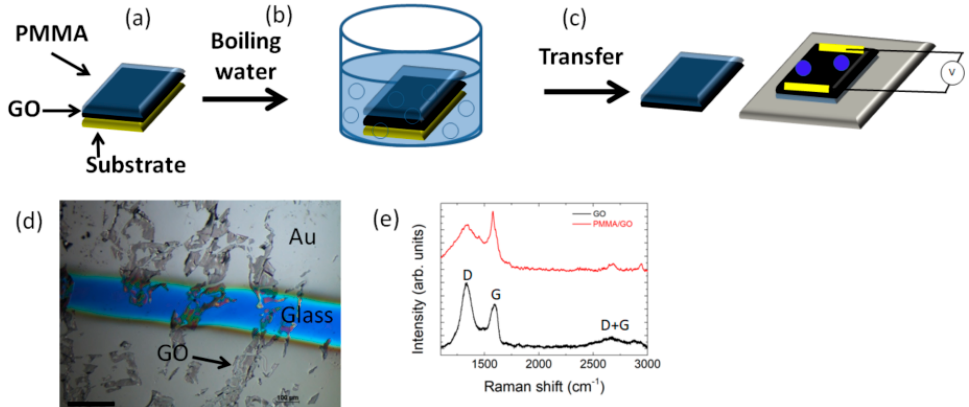
Figure 3. Scheme of transfer method of (GO). ( a ) poly(methyl methacrylate) (PMMA) was deposited on GO. ( b ) The substrate was then immersed in boiling water to promote the detachment of PMMA. ( c ) Transfer onto the target substrate. ( d ) Optical image of PMMA/GO on the target glass substrate between gold electrodes; the scale bar indicates 100 μ m. ( e ) Raman spectra of GO and PMMA/GO film from 1000 cm − 1 to 3200 cm − 1 showing the characteristics D, G, and D + G peaks.